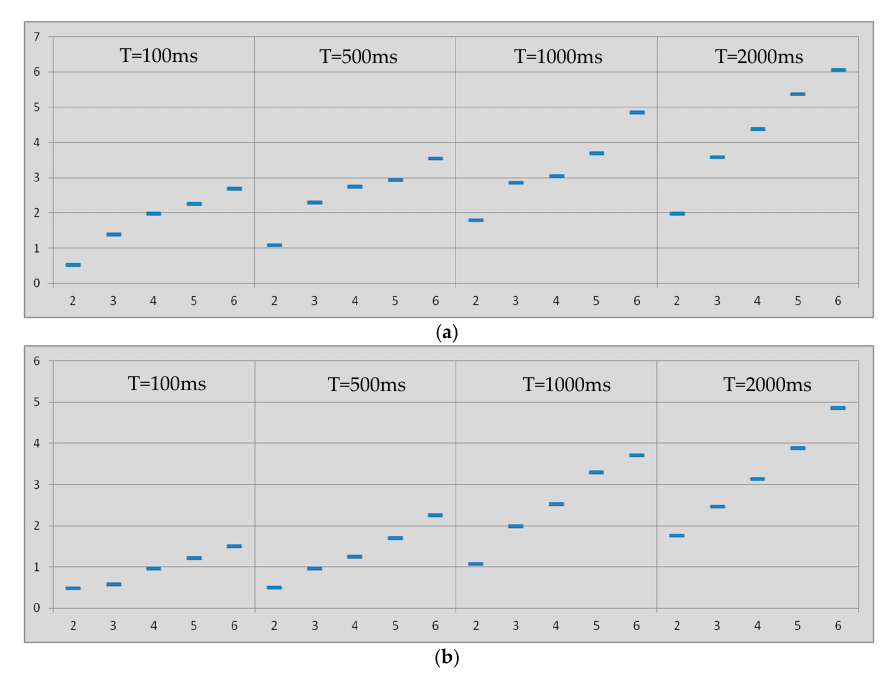
Figure 4. Latency (vertical, seconds) vs. amount of hops (horizontal). Links always in park mode. Inactivity intervals (from left to the right): 100, 500, 1000 and 2000 ms. ( a ) master-to-slave communication; ( b ) slave-to-master communication.